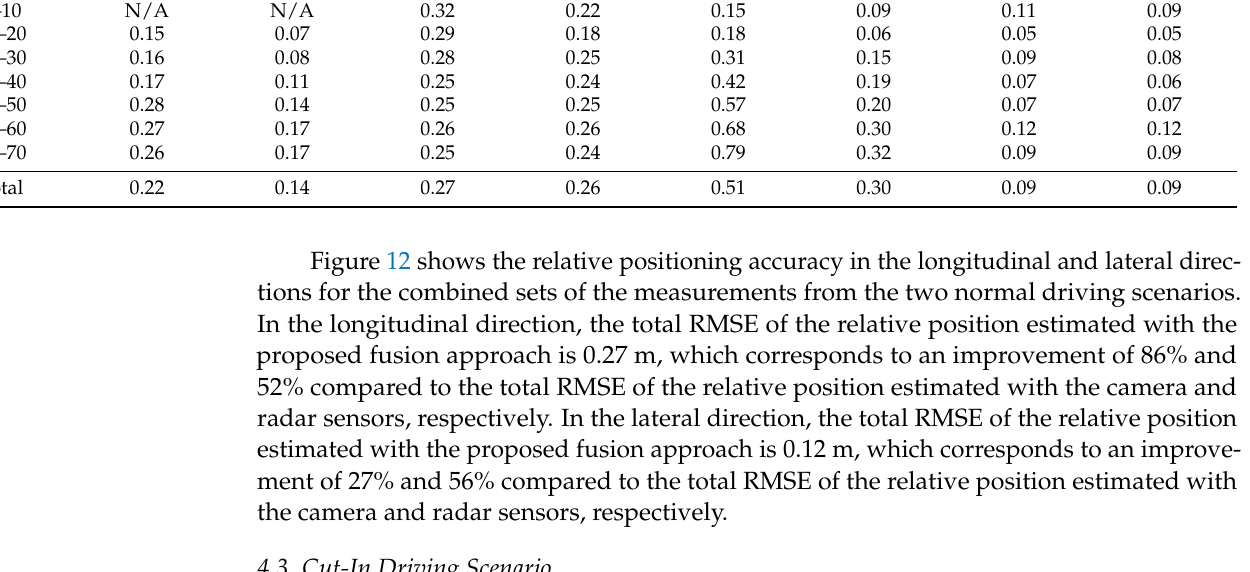
Table 10. Relative positioning accuracy in the lateral direction for the measurements obtained during the normal driving scenario 2. Camera Lat. Position Error Radar Lat. Position Data Range (m)